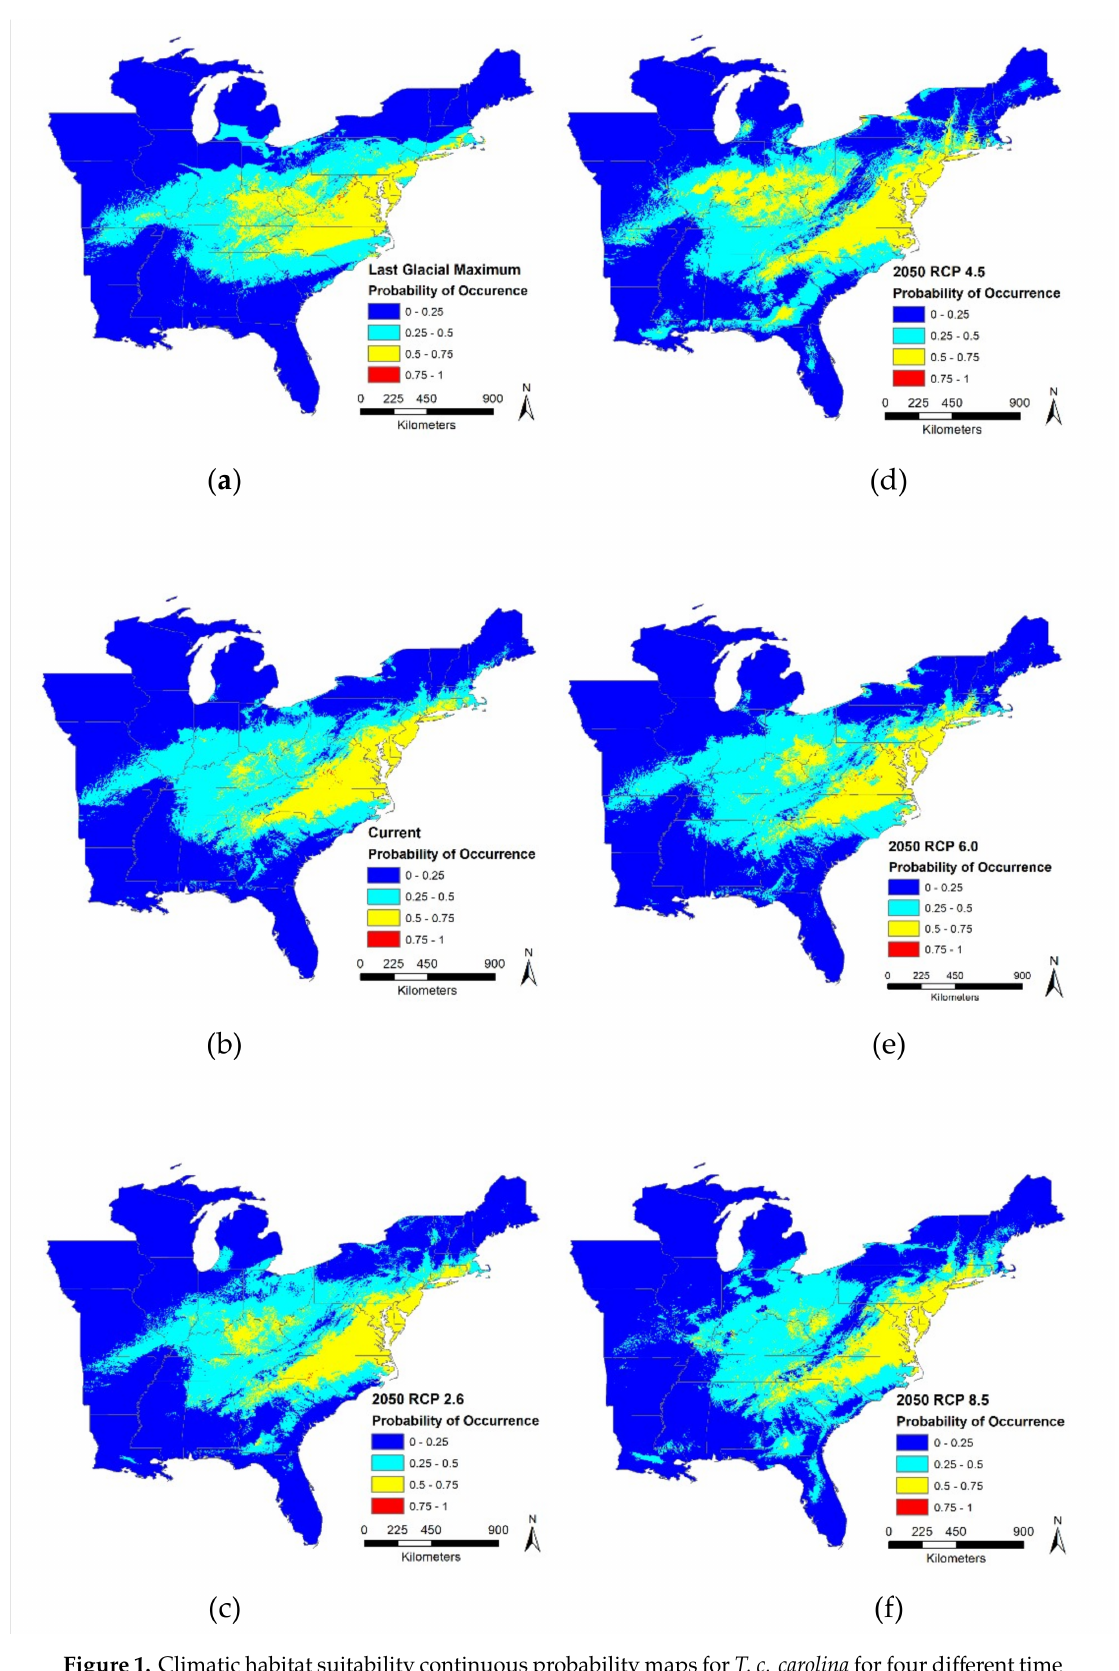
Figure 1. Climatic habitat suitability continuous probability maps for T. c. carolina for four di ff erent time periods: ( a ) Last Glacial Maximum (LGM); ( b ) Current; ( c ) 2050 Representative Concentration Pathway (RCP) 2.6; ( d ) 2050 RCP 4.5; ( e ) 2050 RCP 6.0; ( f ) 2050 RCP 8.5. Color changes indicate probability of suitability, with blue indicating low to no probability and red indicating high